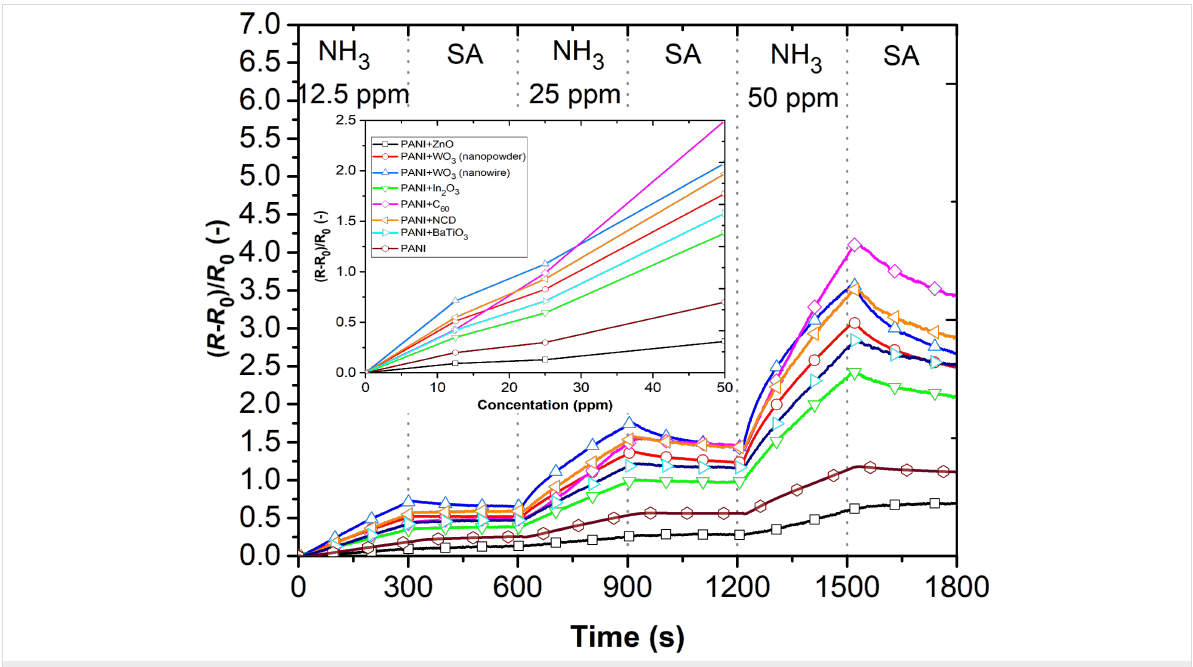
Figure 7: The responses of sensing layers for different concentrations of NH 3 .